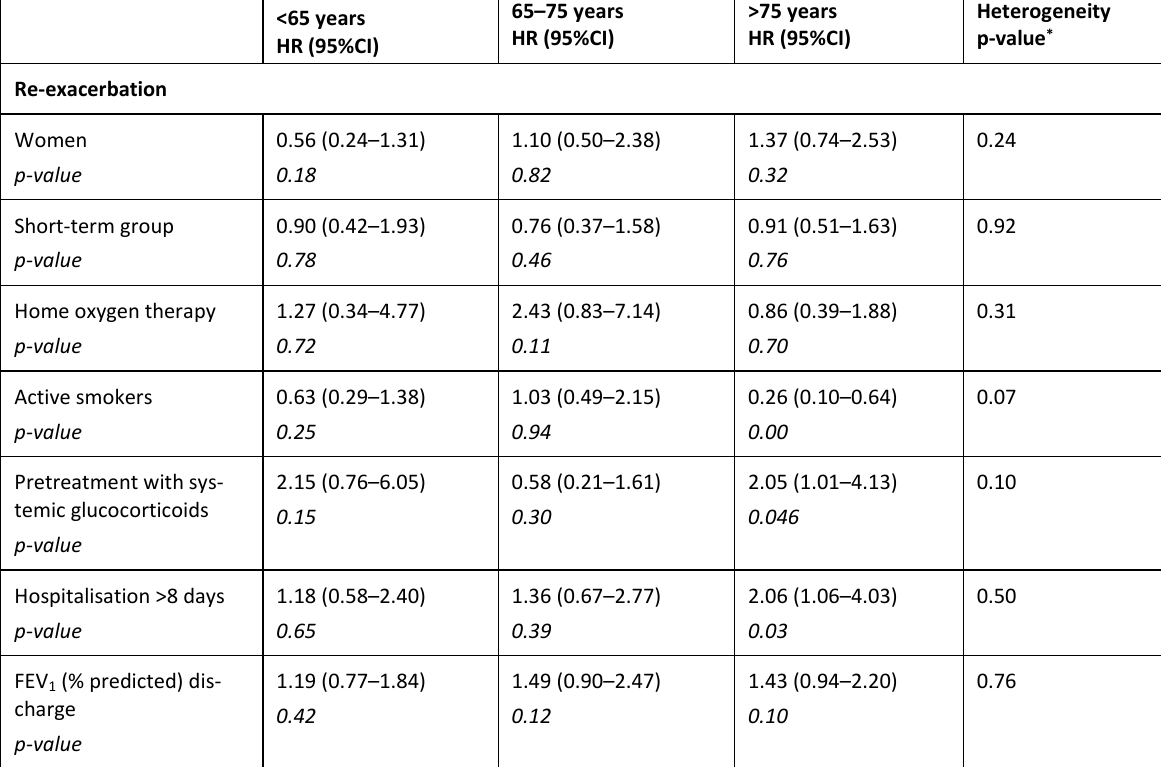
Table S2A: Multivariate analysis of time to re-exacerbation or re-exacerbation and/or death stratified by age at